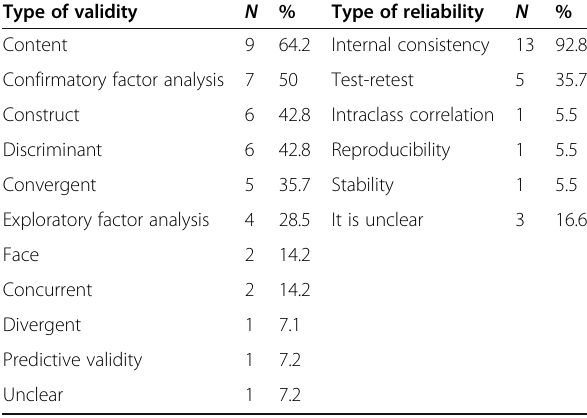
Table 3 Types of validity and reliability used in the studies included in this systematic